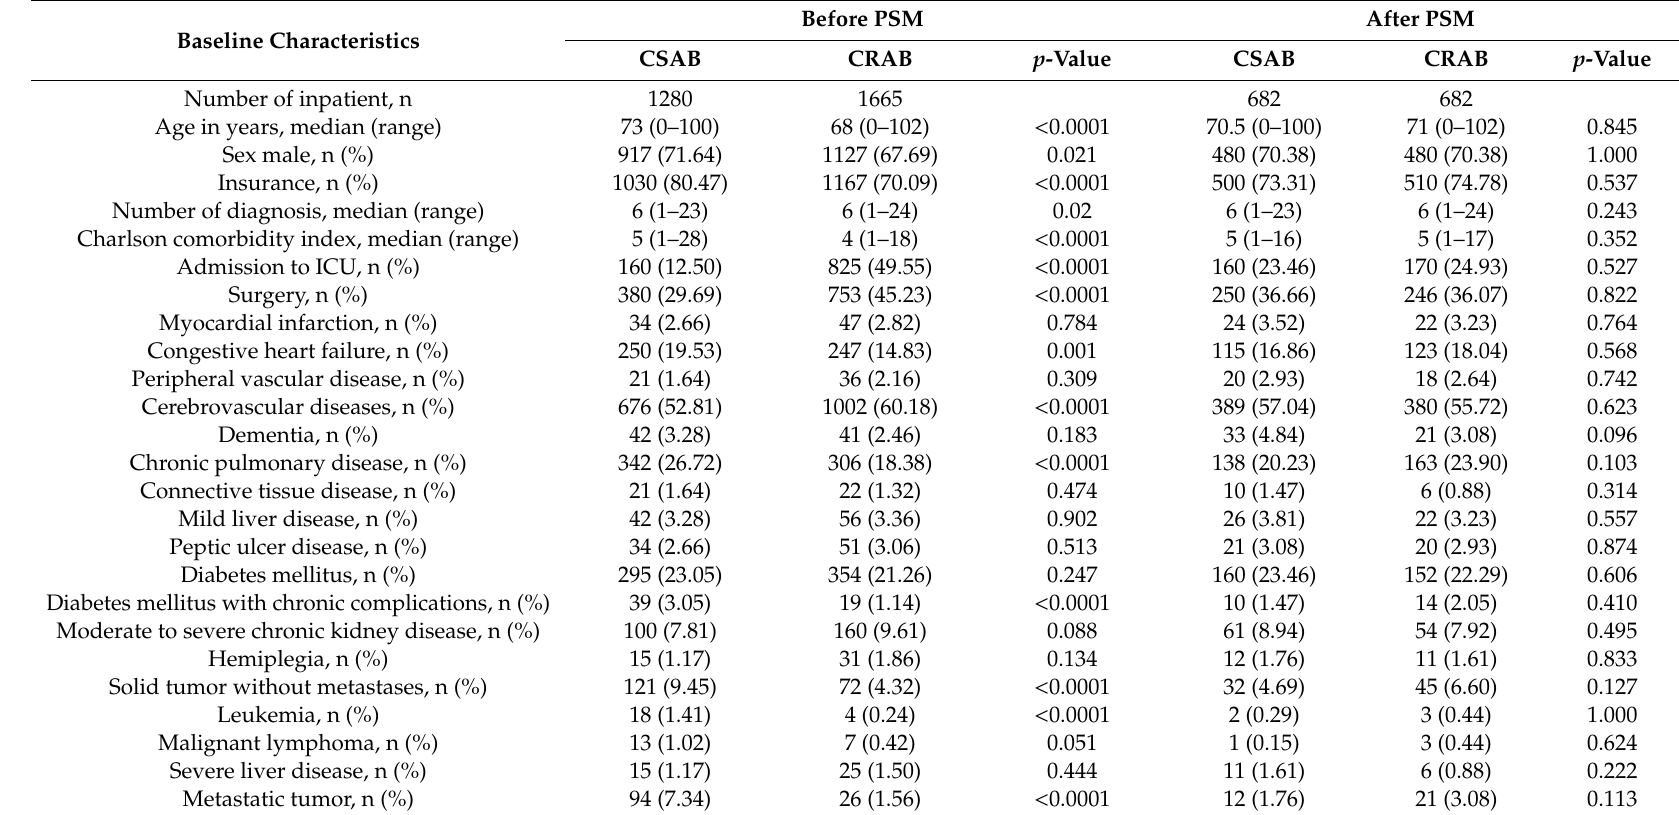
Table 3. Characteristics of the patients with CRAB and CSAB before and after